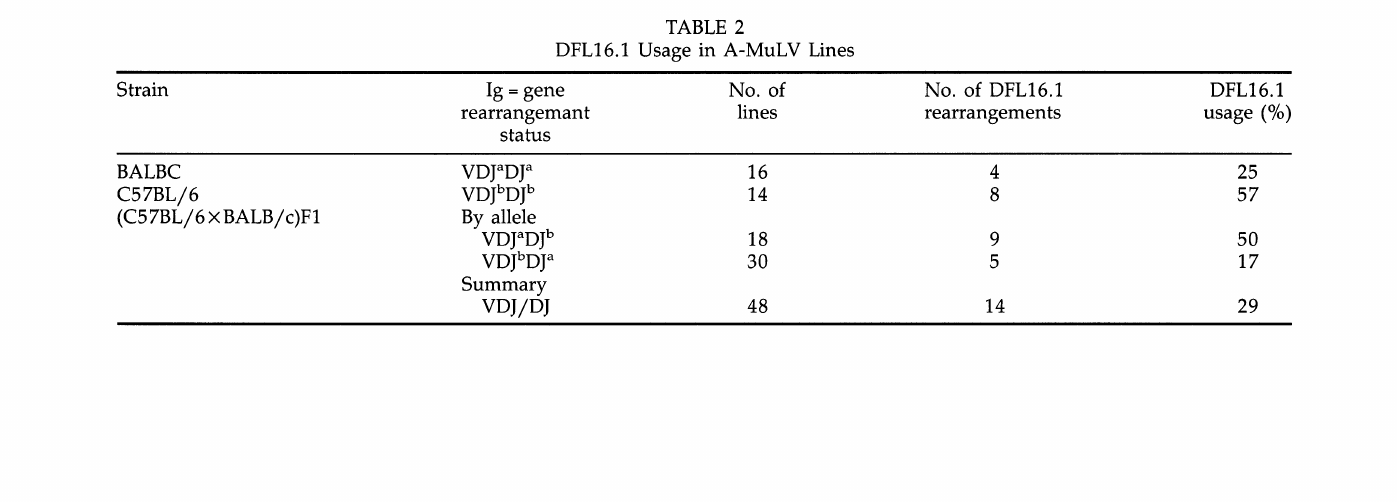
TABLE 2 DFL16.1 Usage in A-MuLV